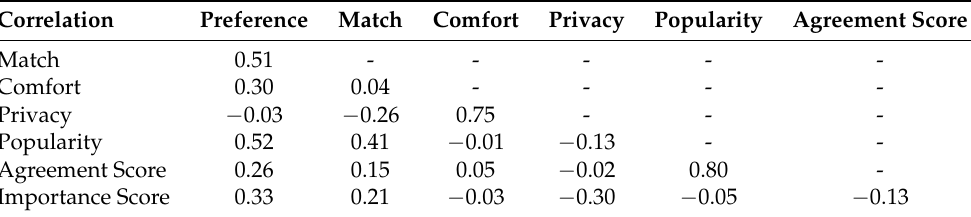
Table 7. The correlation (R) between different ratings a of microgestures on the proposed microgesture–command set.